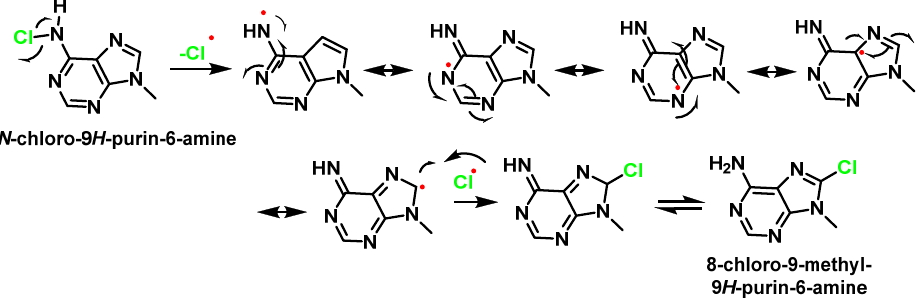
Figure 47. Possible mechanism of formation of 8-chloro-9-methyl-9H-purin-6-amine from the N - chloro-9H-purin-6-amine derivative and formation of the N -centred radical.